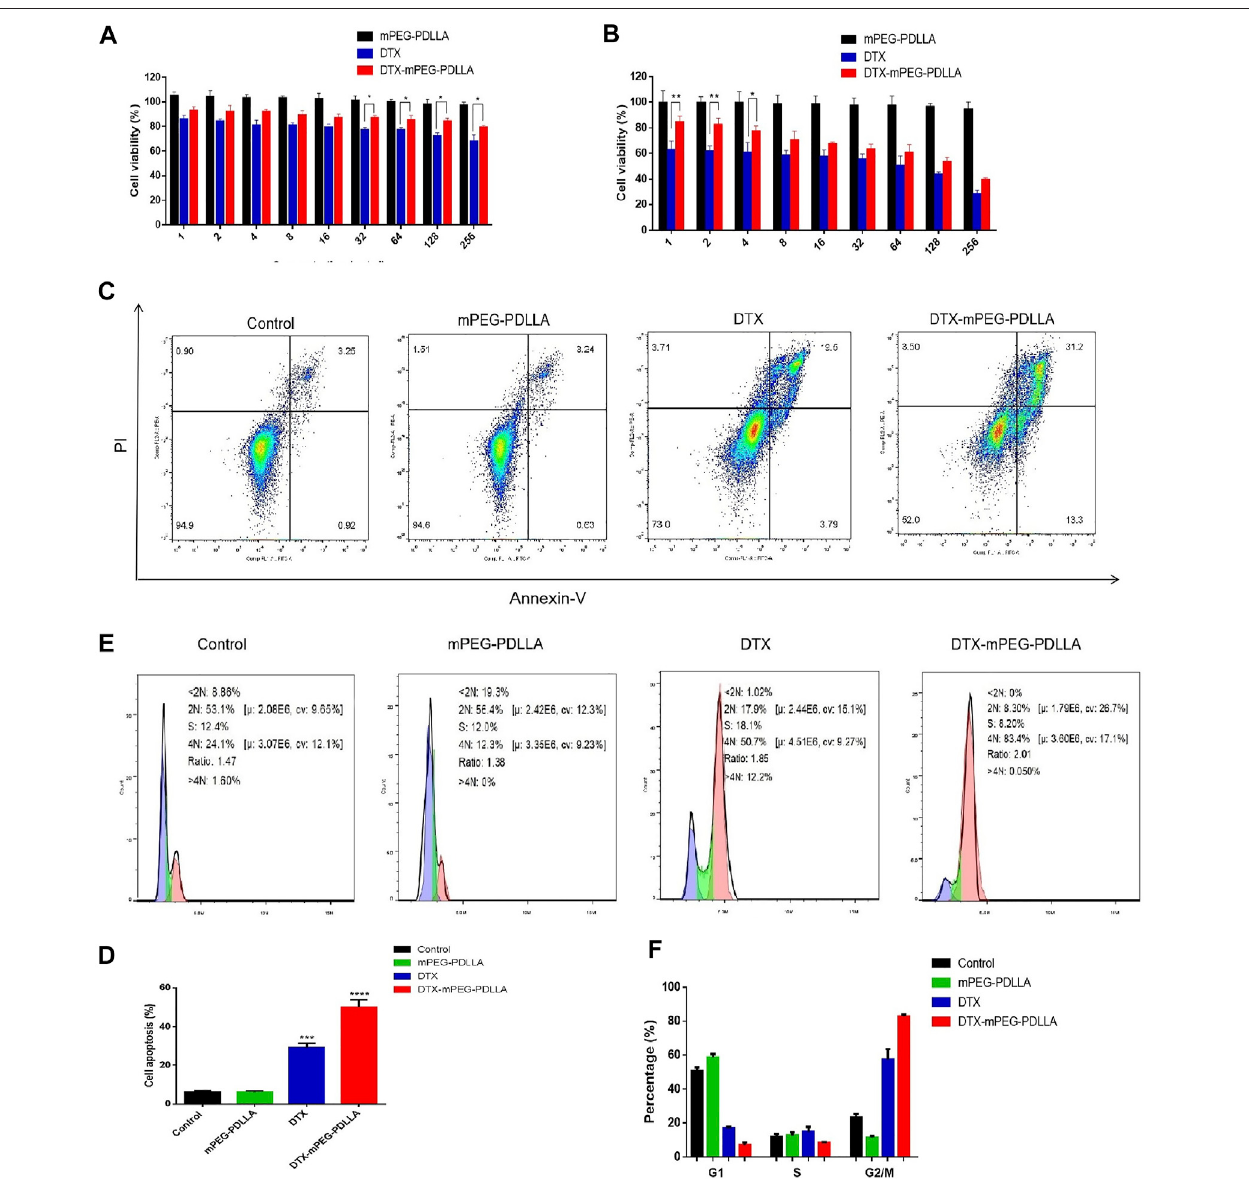
FIGURE4| Antitumor activity ofDTX-mPEG-PDLLAmicellesinovarian cancercells. (A,B) CytotoxicityofmPEG-PDLLA,DTX,and DTX-mPEG-PDLLA micellesin SKOV-3 human ovarian cancer cells treated for 24 and 48 h, respectively ( n = 3, mean ± SD); * p < 0.05 and ** p < 0.01. (C) Apoptosis induction of SKOV-3 cells treated with mPEG-PDLLA, DTX, and DTX-mPEG-PDLLA for 48 h analyzed by the Annexin V-FITC Apoptosis Detection Kit. (D) Results representing three-independent experiments; *** p < 0.001, **** p < 0.0001 vs. the control group. (E,F) Cell cycle assays and analysis of mPEG-PDLLA, DTX, and DTX-mPEG-PDLLA micelles in SKOV-3 cells treated for 48 h, respectively ( n = 3, mean ±